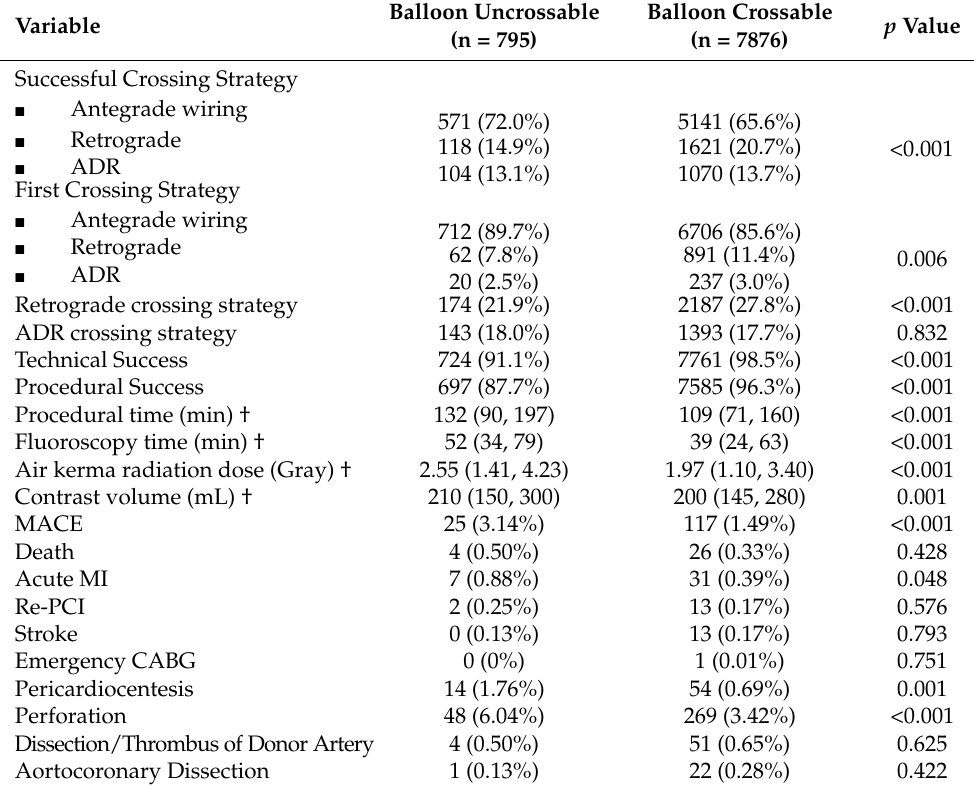
Table 2. Procedural characteristics and outcomes of study patients, classified according to the presence of balloon uncrossable